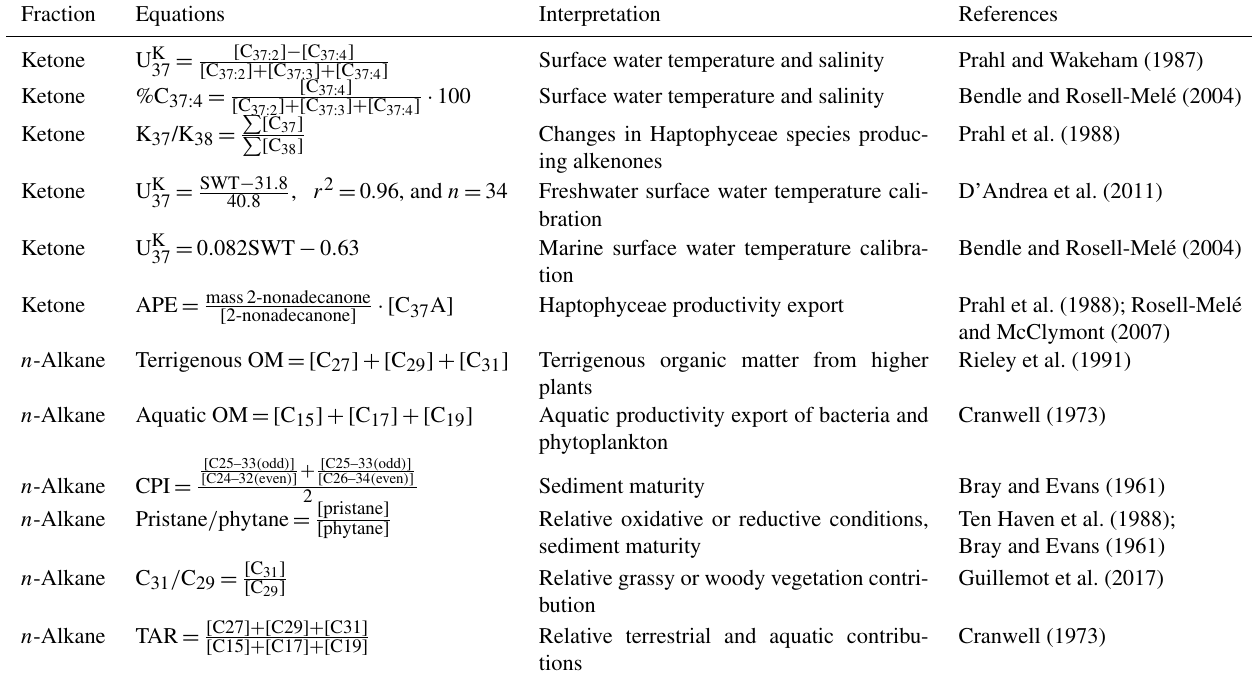
Table 1. Summary of the lipid biomarker proxies